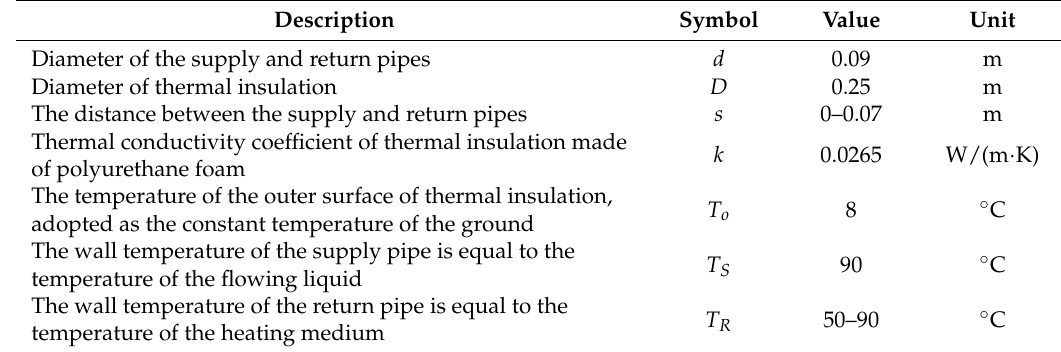
Table 1. Boundary conditions, circular insulation parameters, and dimensions of a twin pipe.